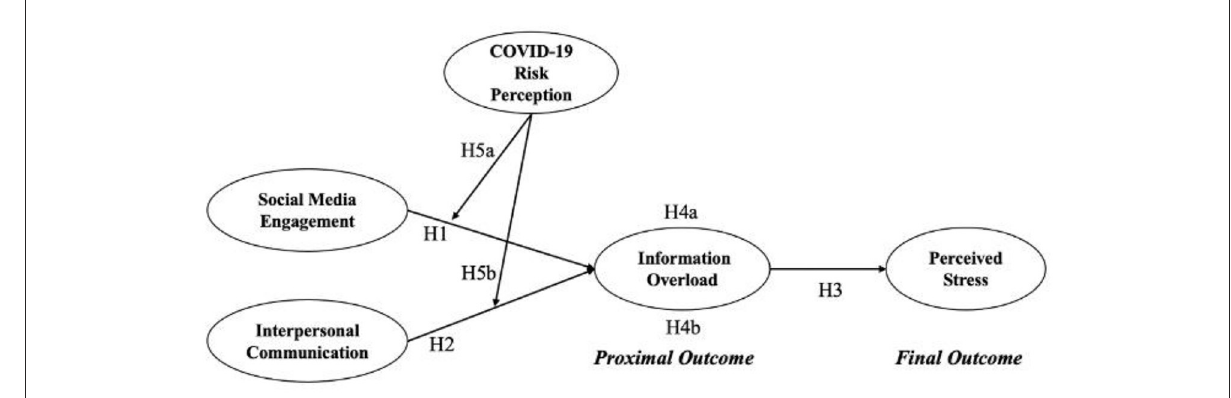
FIGURE1 Conceptual